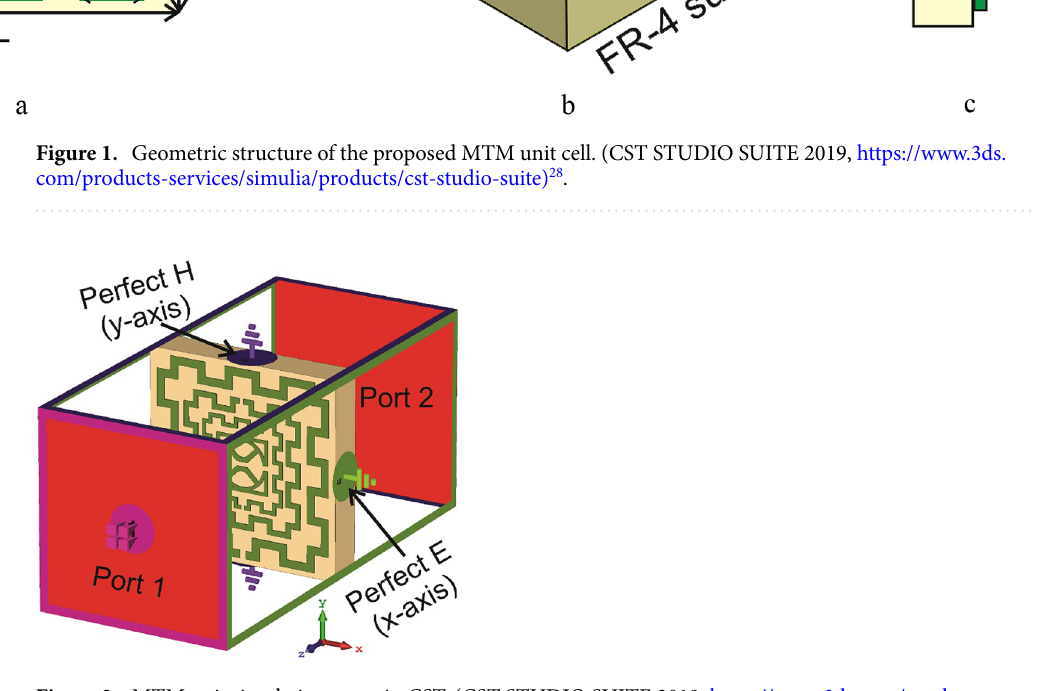
Figure 2. MTM unit simulation setup in CST. (CST STUDIO SUITE 2019, https:// www. 3ds. com/ produ cts- servi ces/ simul ia/ produ cts/ cst- studio- suite) 28